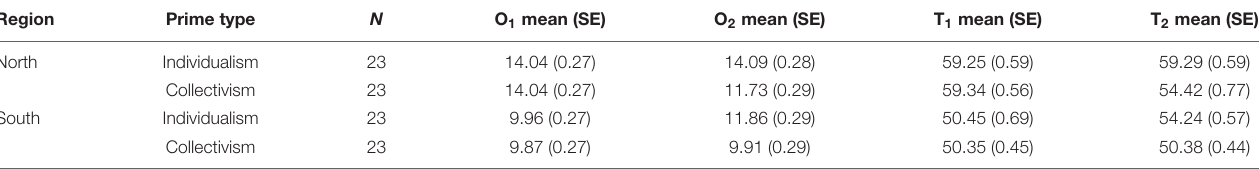
TABLE 1 | Means and standard errors of original and standard EFT scores stratified by region and prime type.